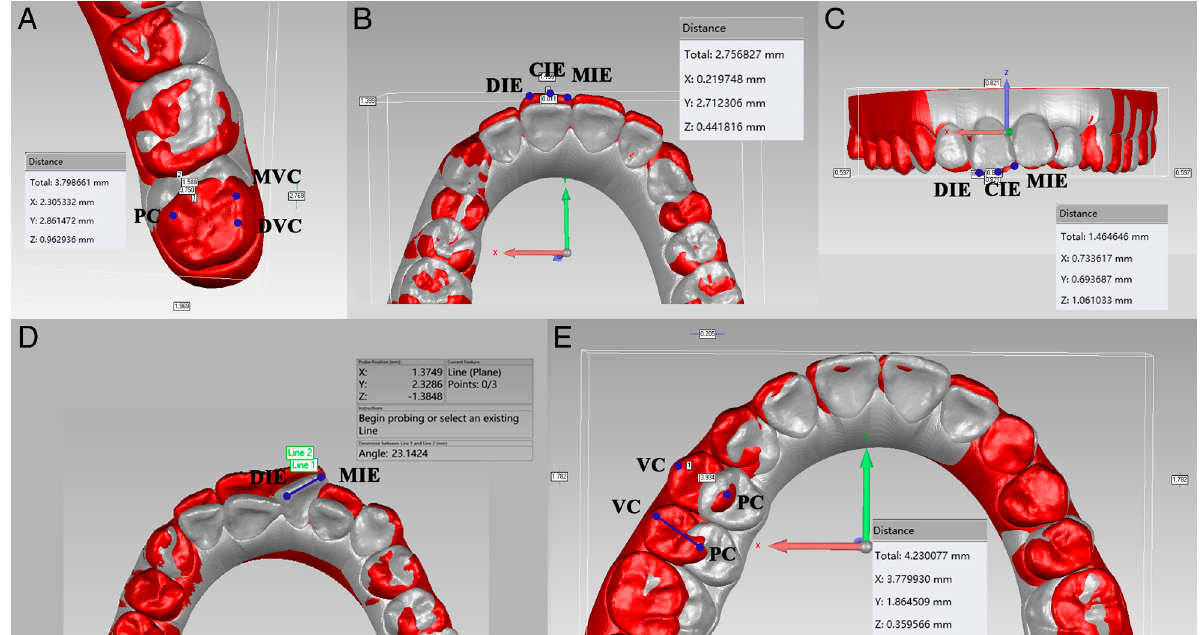
Figure 3. Measurement of OTM. (a) Molar distalization was measured at points of each cusp tip of molars; (b) Points of incisor edges were used to meas- ure anterior retraction; (c) Measurement of anterior intrusion; (d) Lines of incisor edges were used to measure angle of anterior rotation; (e) Measurement of posterior expansion. CIE: central incisal edge; DIE: distal incisal edge; DVC: distal vestibular cusp tip; MVC: mesial vestibular cusp tip; MIE: mesial incisal edge; PC: palatal cusp tip; VC: vestibular cusp